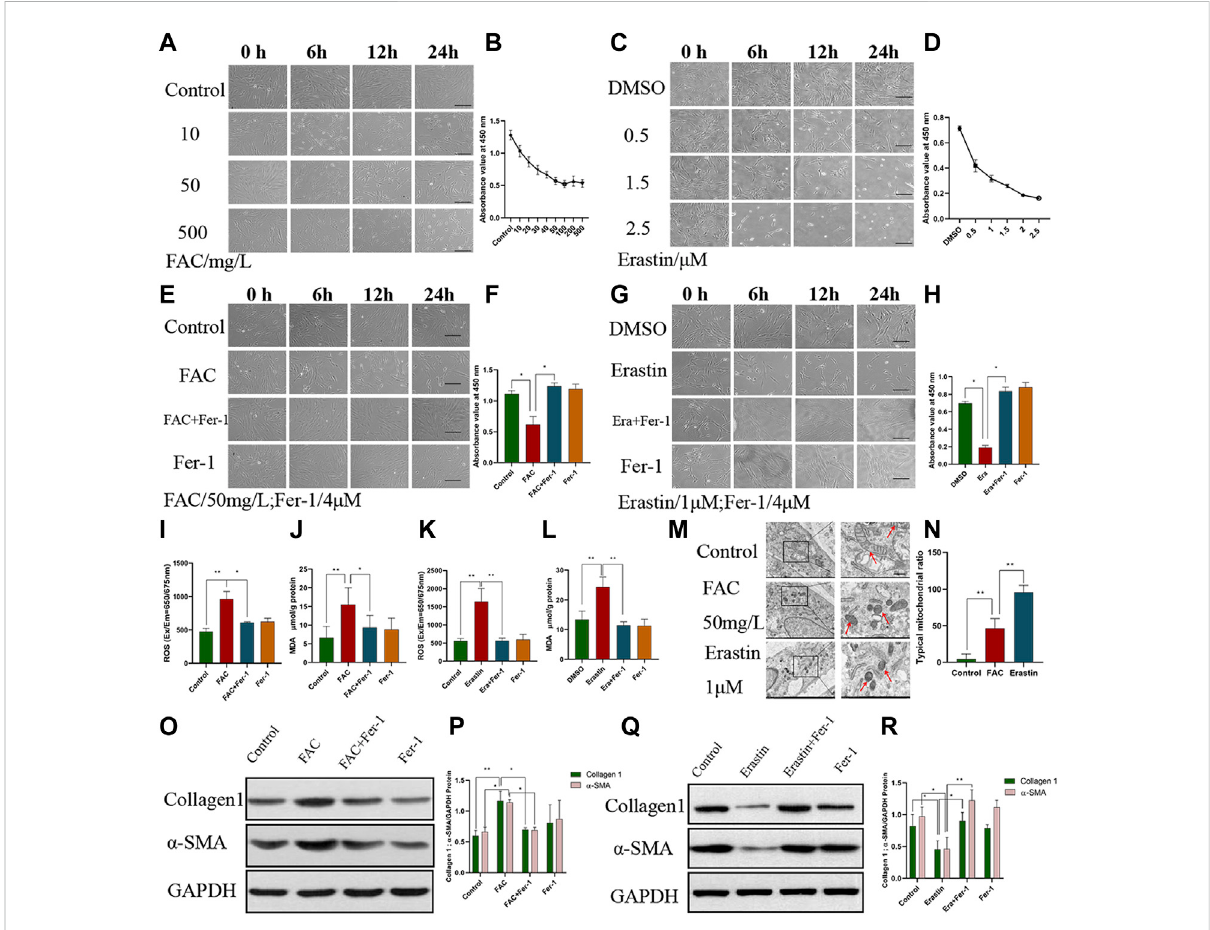
Ferroptosis induced by Ferric ammonium citrate (FAC) could aggravate fi brosis. (A – B) Visualization of HEcESCs viability in the different dose of FAC treated groups (A) over time and CCK8 assay (B) in different treated groups over time. (C – D) Visualization of HEcESCs viability in the different dose of erastin treated groups (C) over time and CCK8 assay (D) in different treated groups over time. With the increasing in drug concentration, all cells in the erastin group tended to be sensitive to ferroptosis, but the cells in the FAC group didn ’ t exist the same phenomenon after the FAC reached50mg/L. (E – F) VisualizationofHEcESCsviabilityinFACandferroptosisinhibitorFer-1 (E) andCCK8assay (F) indifferenttreatedgroupsover time. (G – H) Visualization of HEcESCs viability in erastin and ferroptosis inhibitor Fer-1 (G) and CCK8 assay (H) in different treated groups over time.The induction of both reagents can be blocked by ferroptosis inhibitor Fer-1. Scar bars: 50 μ m. (I) The ROS level of HEcESCs treated with FAC and/or Fer-1. (J) The MDA level of HEcESCs treated with FAC and/or Fer-1. (K) The ROS level of HEcESCs treated with Erastin and/or Fer-1. (L) The MDA level of HEcESCs treated with Erastin and/or Fer-1. (M – N) Typical mitochondrial picture of ferroptosis under a transmission electron microscope in different treated groups (M) and statistical results of typical mitochondrial ratio (N) . Only a part of cell mitochondria changed in the FAC-treated group. Scale bars: 500 nm. (O – P) . Representative images (O) and quantitative analyses (P) of the fi brosis-related protein Collagen1 and a-SMA expression levels of HEcESCs in FAC-treated groups. (Q – R) . Representative images (Q) and quantitative analyses (R) of the fi brosis-related protein Collagen1 and a-SMA expression levels of HEcESCs in erastin-treated groups. FAC treatment promoted fi brosis-related protein expressions, while erastin exerted opposite effects. Summary data are presented as the mean ± SEM. Signi fi cance in (F,H – L,N) was calculated using a one-way analysis of variance; Signi fi cance in P and R was calculated using a two-way analysis of variance; * p < 0.05, ** p < 0.01, *** p <